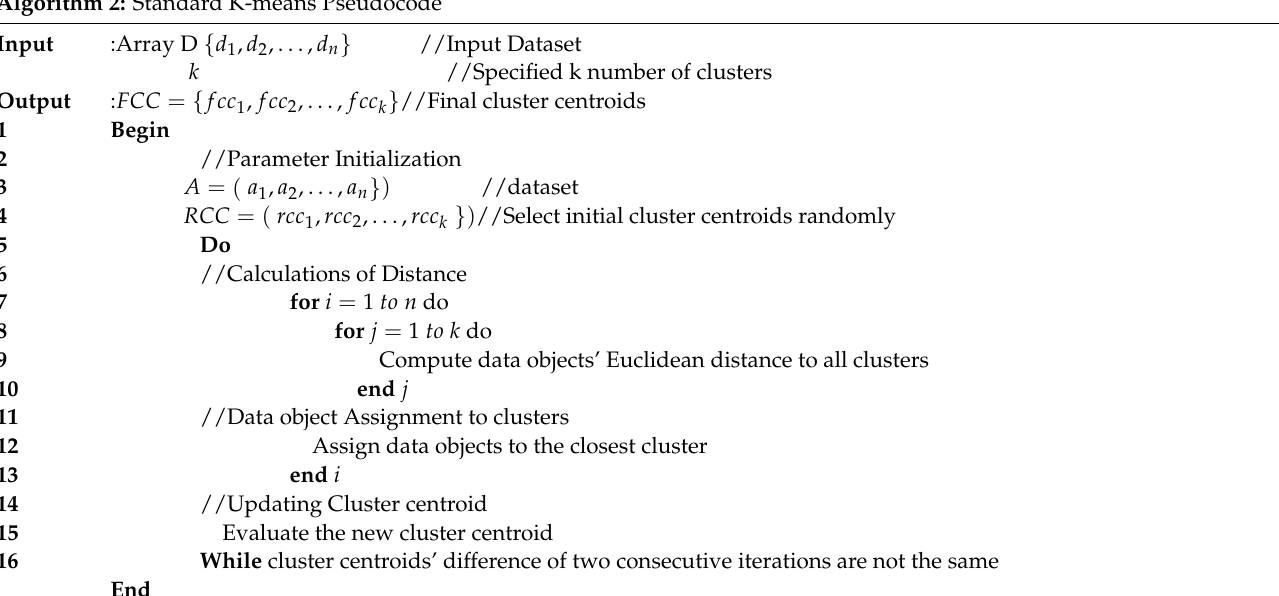
Algorithm 2: Standard K-means